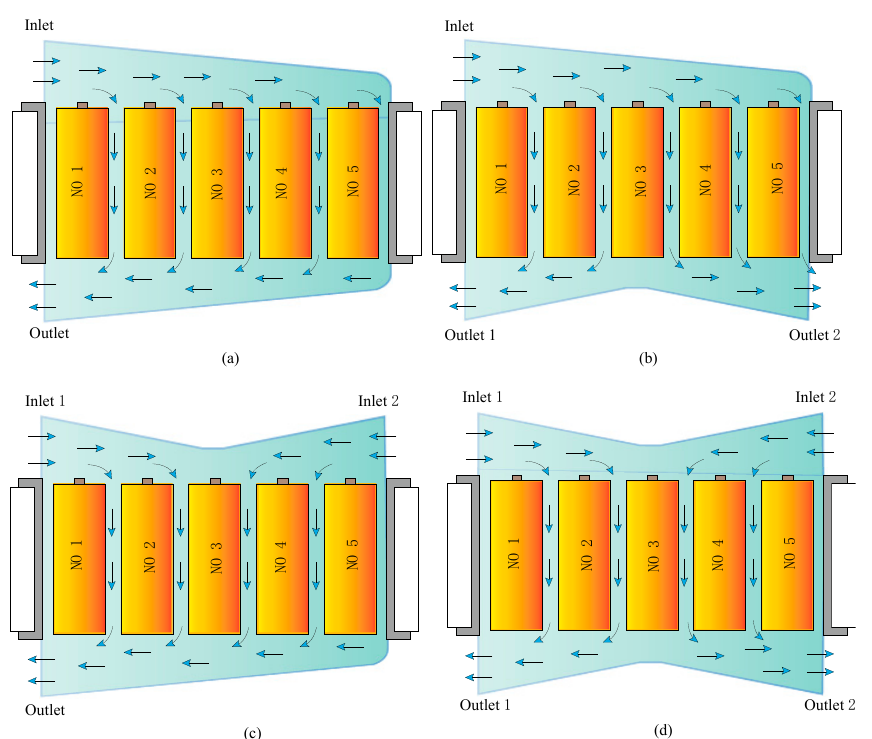
Figure 7. Schematic diagram of air inlet and outlet scheme. ( a ) One inlet one outlet (case 2); ( b ) one inlet two outlets (case 3); ( c ) two inlets one outlet (case 4); and ( d ) two inlets two outlet (case 5).